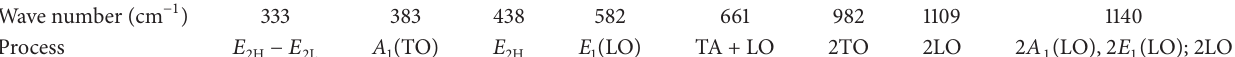
Table 1: The wave numbers (in cm − 1 ) of the first- and second-order Raman spectra observed in ZnO nanorods.